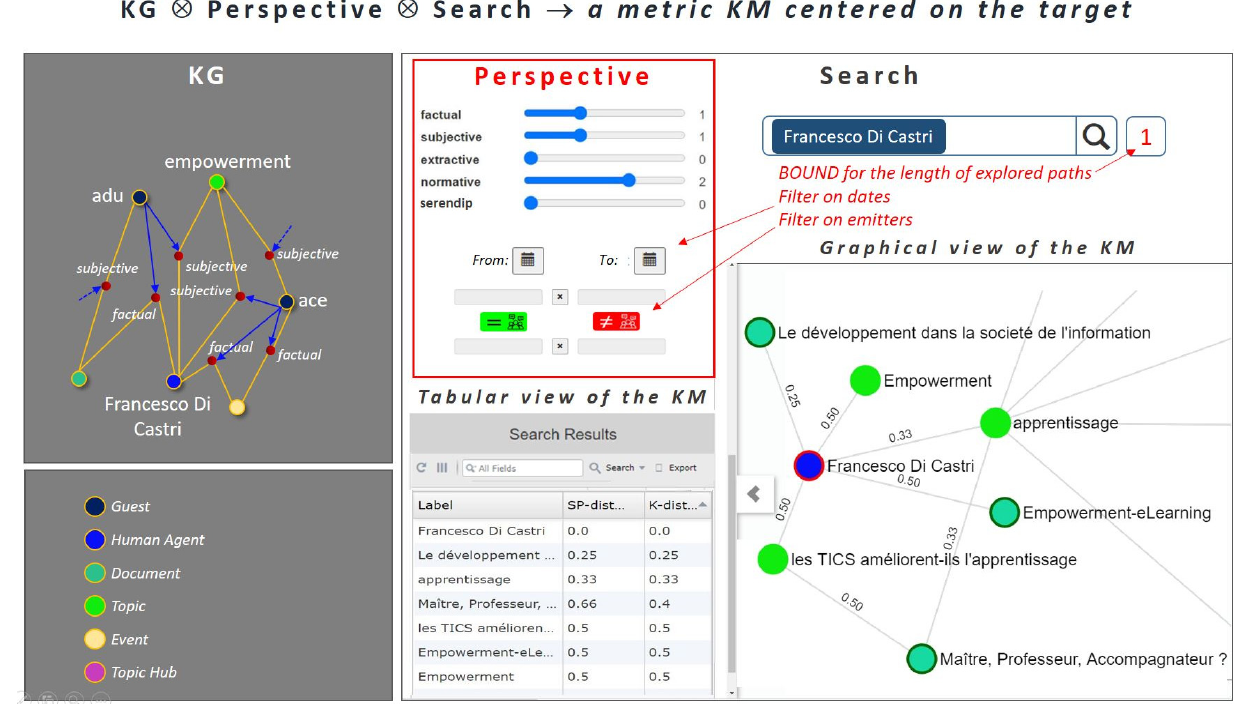
Figure 2. How the community members discover knowledge resources in the medium: the tabular and graphical views of a knowledge map resulting from the query “Francesco Di Castri” under a chosen perspective. In grey on the left: a small extract of the knowledge graph.